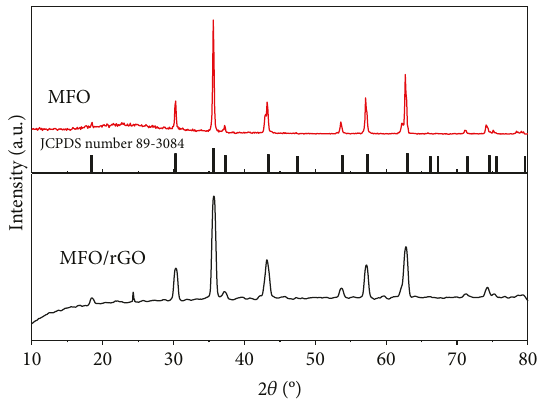
Figure 1: The XRD patterns of MFO and MFO/rGO